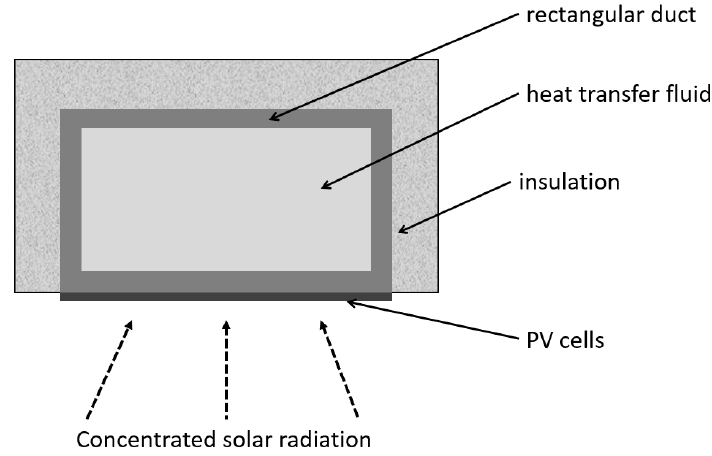
Figure 5. The cross-sectional view of typical rectangular-duct heat receiver.